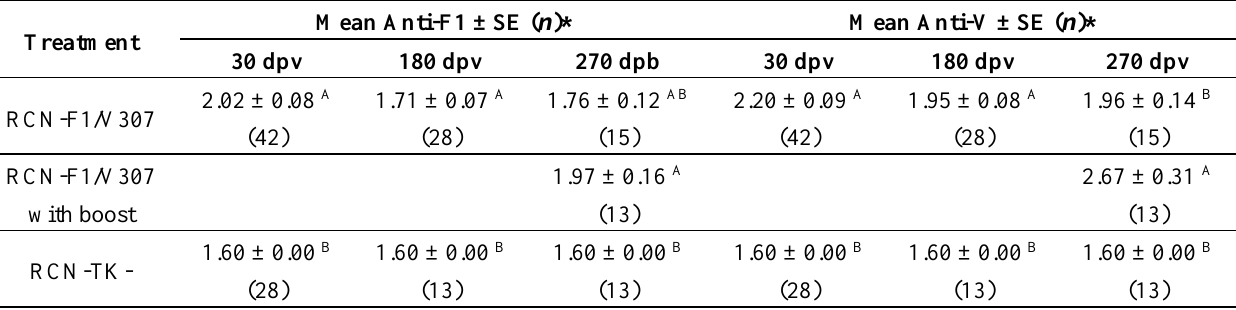
Table 6. Geometric mean anti-F1 and anti-V antibody titers ± standard error (SE) were compared between prairie dogs that consumed baits containing RCN-F1/V307 (with or without a boost) and RCN-TK- (placebo). Antibody titers were measured at 30, 180 and 270 days post initial vaccination